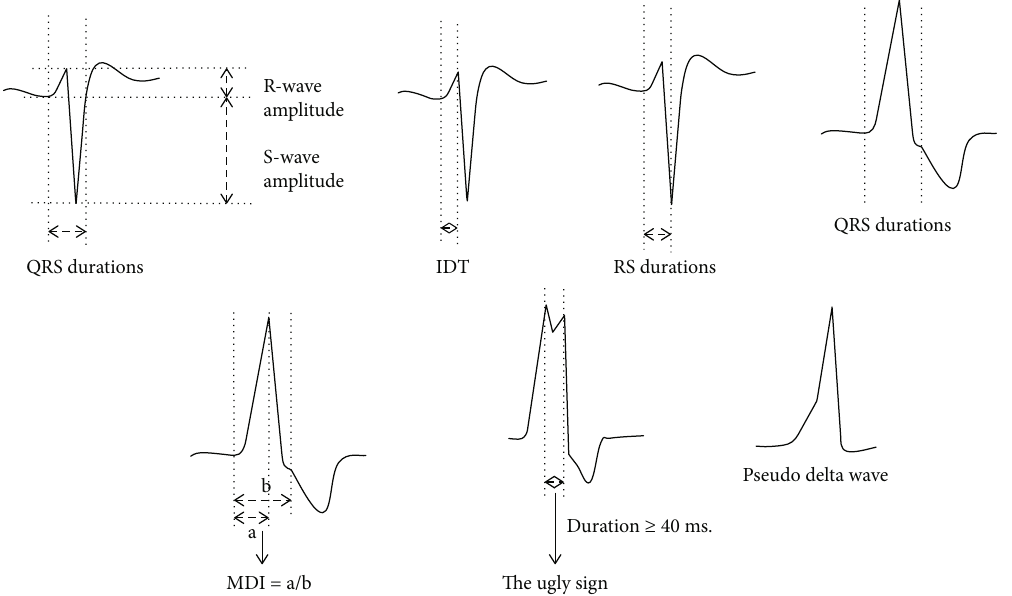
Figure 1: The measurement of the electrocardiogram